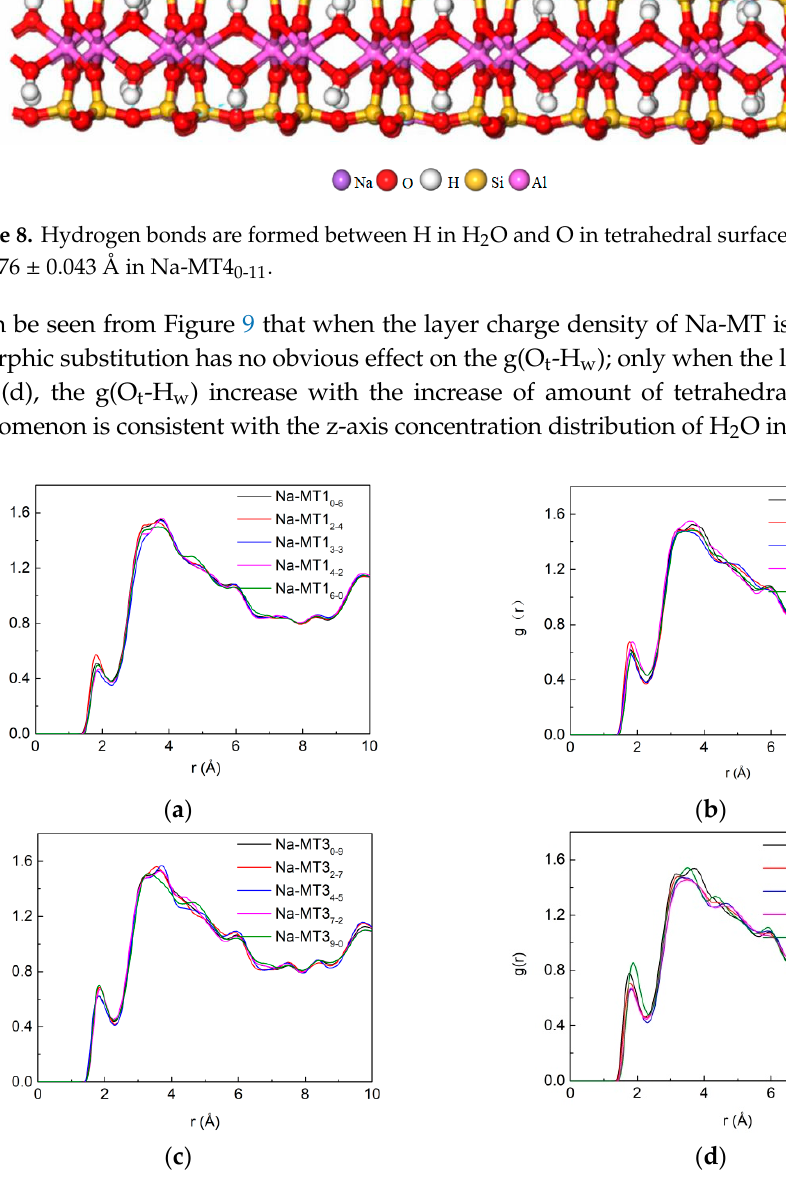
Figure 9. The RDF of O t -H w in Na-MT with different isomorphic substitution sites, ( a ) Na-MT1; ( b ) Na-MT2; ( c ) Na-MT3; ( d ) Na-MT4.